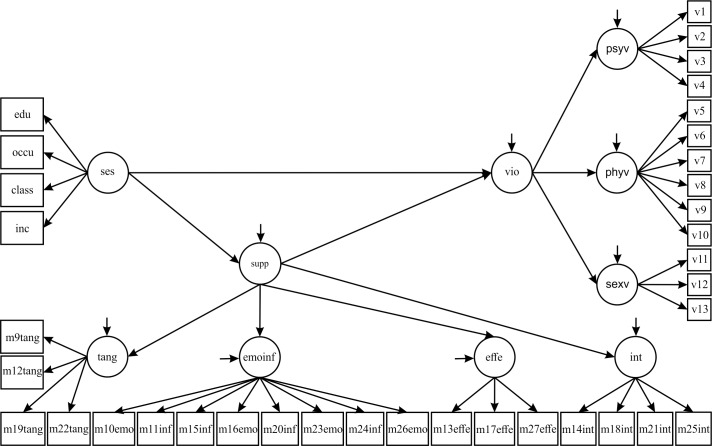
Structural equation modeling of general violence against pregnant women in São Luís, 2010–2011.ses: socioeconomic status. class: economic class. inc: family income. occu: occupation of the family head. edu: years of study of the pregnant woman. vio: general violence was analyzed as a three-dimensional second-order factor structure. Questions about psychological (v1-v4), physical (v5-v10) and sexual violence (v11-v13) were presented in the text that described the validation of the WHO VAW (World Health Organization–Violence against Women) instrument for this population of pregnant women [22]. psyv: psychological violence. phyv: physical violence. sexv: sexual violence. supp: social support. int: positive social interaction support (m14int, m18int, m21int, m25int). emoinf: emotional/informational support (m10emo, m11inf, m15inf, m16emo, m20inf, m23emo, m24inf, m26emo). affe: affectionate support (m13affe, m17affe, m27affe). tang: tangible support (m9tang, m12tang, m19tang, m22tang).